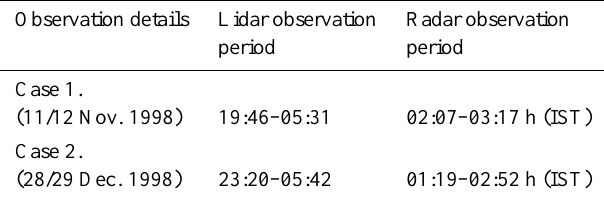
Table 3. Details of tropical cirrus passage over Gadanki site